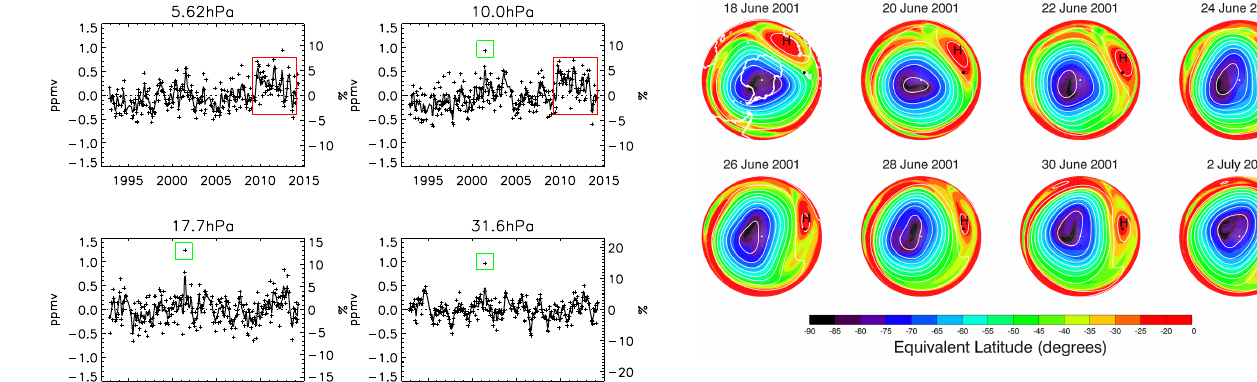
Figure 4. The tracer equivalent latitude (see text) for the Southern Hemisphere at 650K. The location of Lauder (45 ◦ S, 169.7 ◦ E) is indicated by a black dot. White contours are 650K streamlines at constant intervals. The black “H” indicates the location of strong anticyclonic